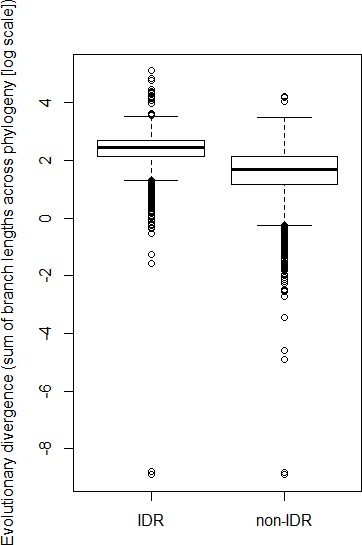
Predicted IDRs in the S. cerevisiae proteome (‘IDR’) are more highly diverged compared to regions that are not predicted to be disordered (‘non-IDR’) (p<2.2×10−16, Wilcoxon test).Boxplot boxes represent the 25th-75th percentile of the data, the black line represents the median, and whiskers represent 1.5*the interquartile range. Outliers fall outside the 1.5*interquartile range, and are represented by unfilled circles.